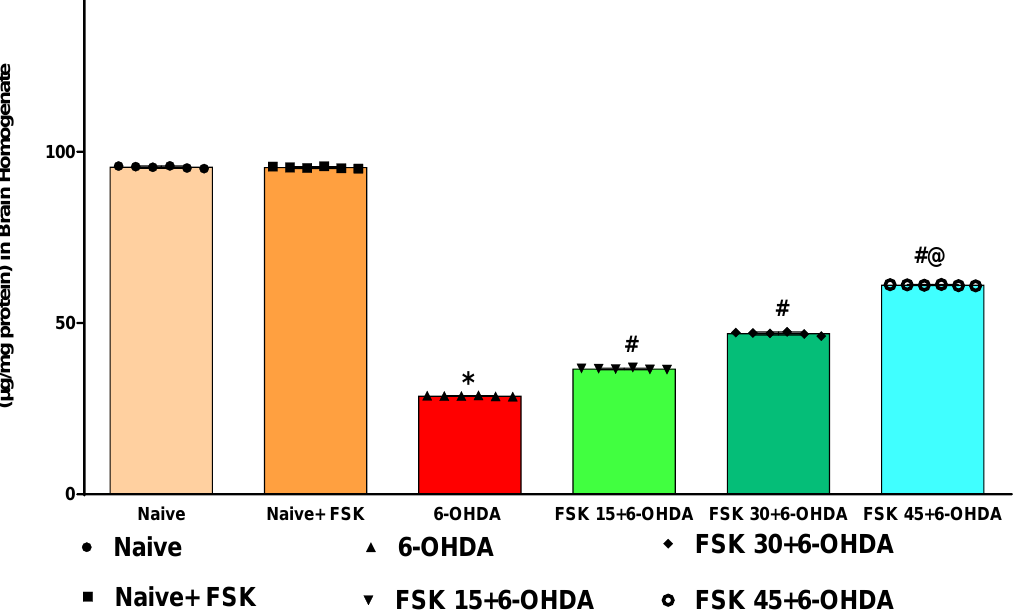
Figure 8. FSK increases myelin basic protein (MBP) levels in the experimental model of PD. Data provided as mean ± SD (n = 6 ) followed by ANOVA (one-way) with post-hoc Tukey’s test. * 6-OHDA ( p < 0.01) compared with naive and naive + FSK ; # FSK15, FSK30, FSK45 (p < 0.01) compared with 6-OHDA ; #@ FSK45 (p < 0.01) compared with FSK30, FSK15.